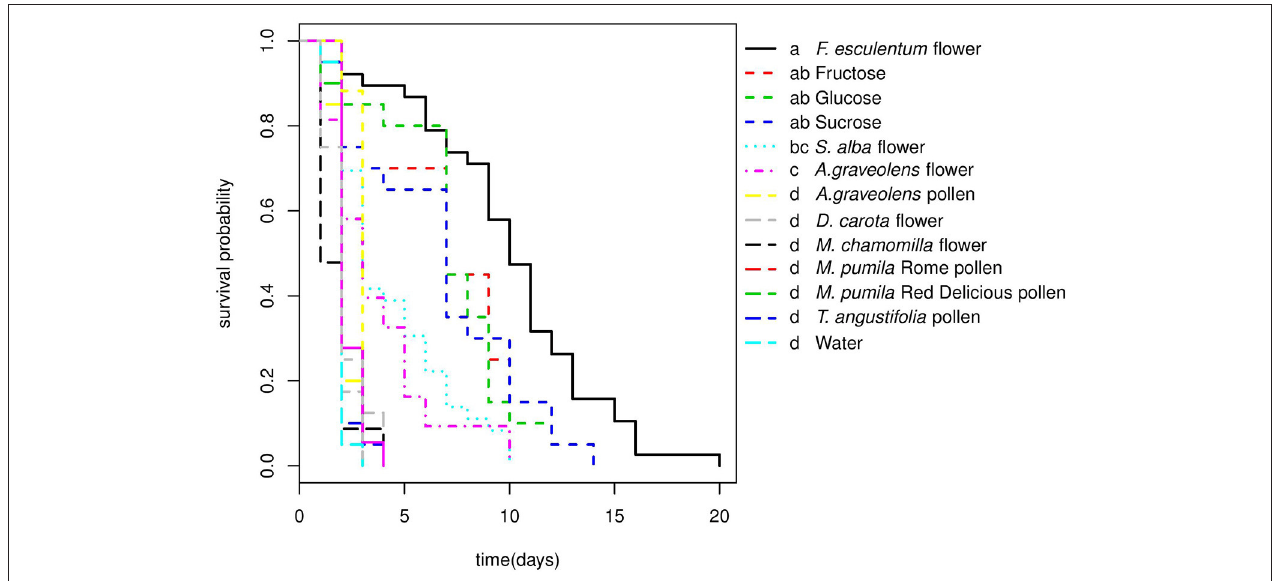
FIGURE 1 | Survival curves of A.bipunctata larvae fed on different non-prey diets. Different letters indicate significant differences among treatments after pairwise comparisons of the survival curves ( p < 0.05).